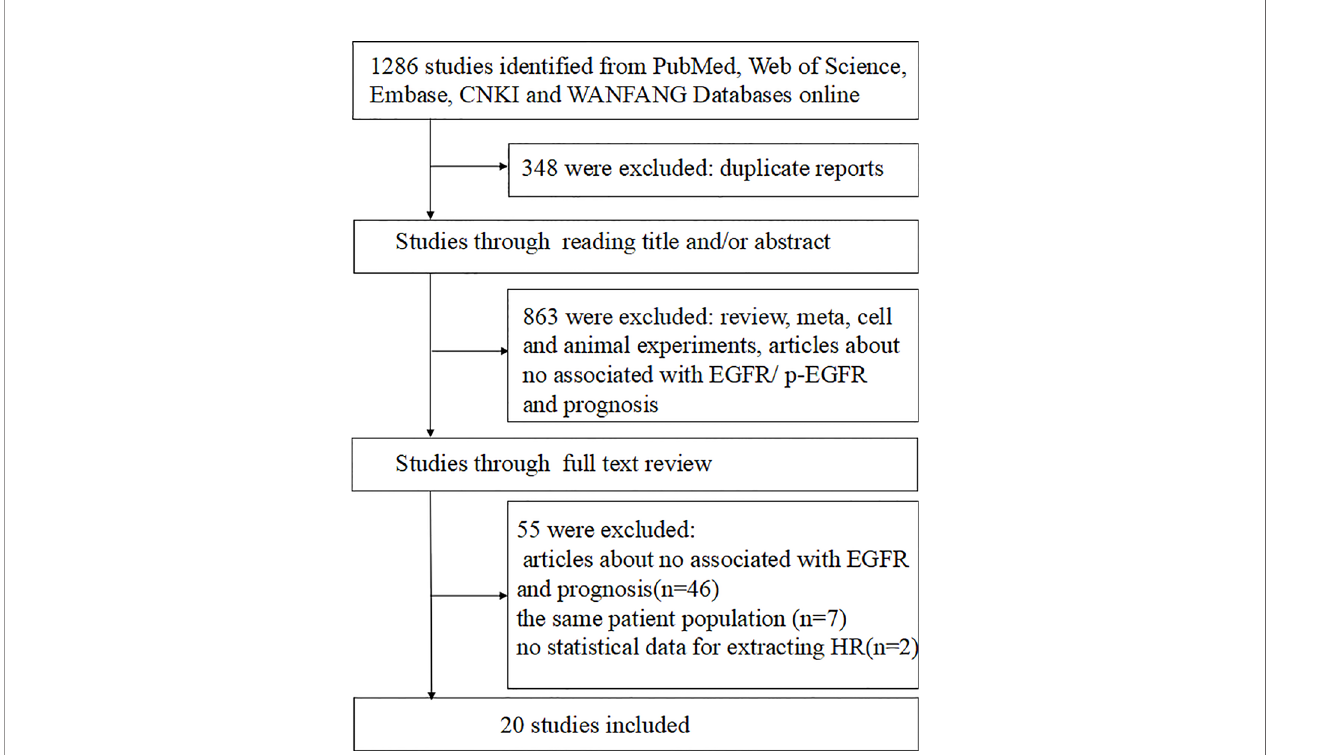
FIGURE 1 | Flow chart of studies selection